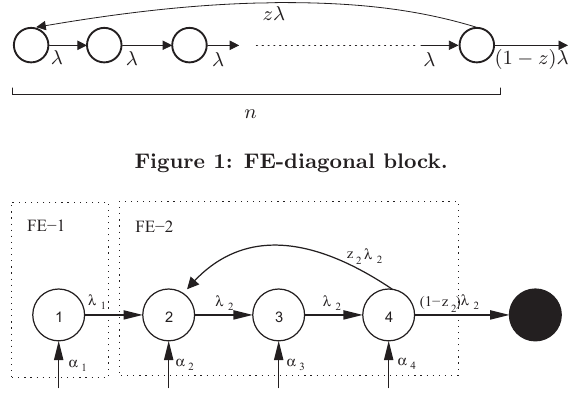
Figure 2: FE-diagonal representation of a generator with a real eigenvalue ( λ 1 ) and a pair of complex